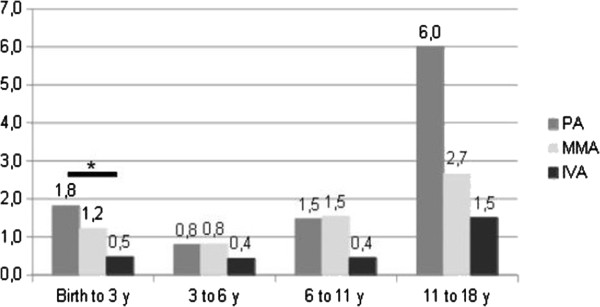
Average number of acute decompensations by patients according to age, except the initial episode.